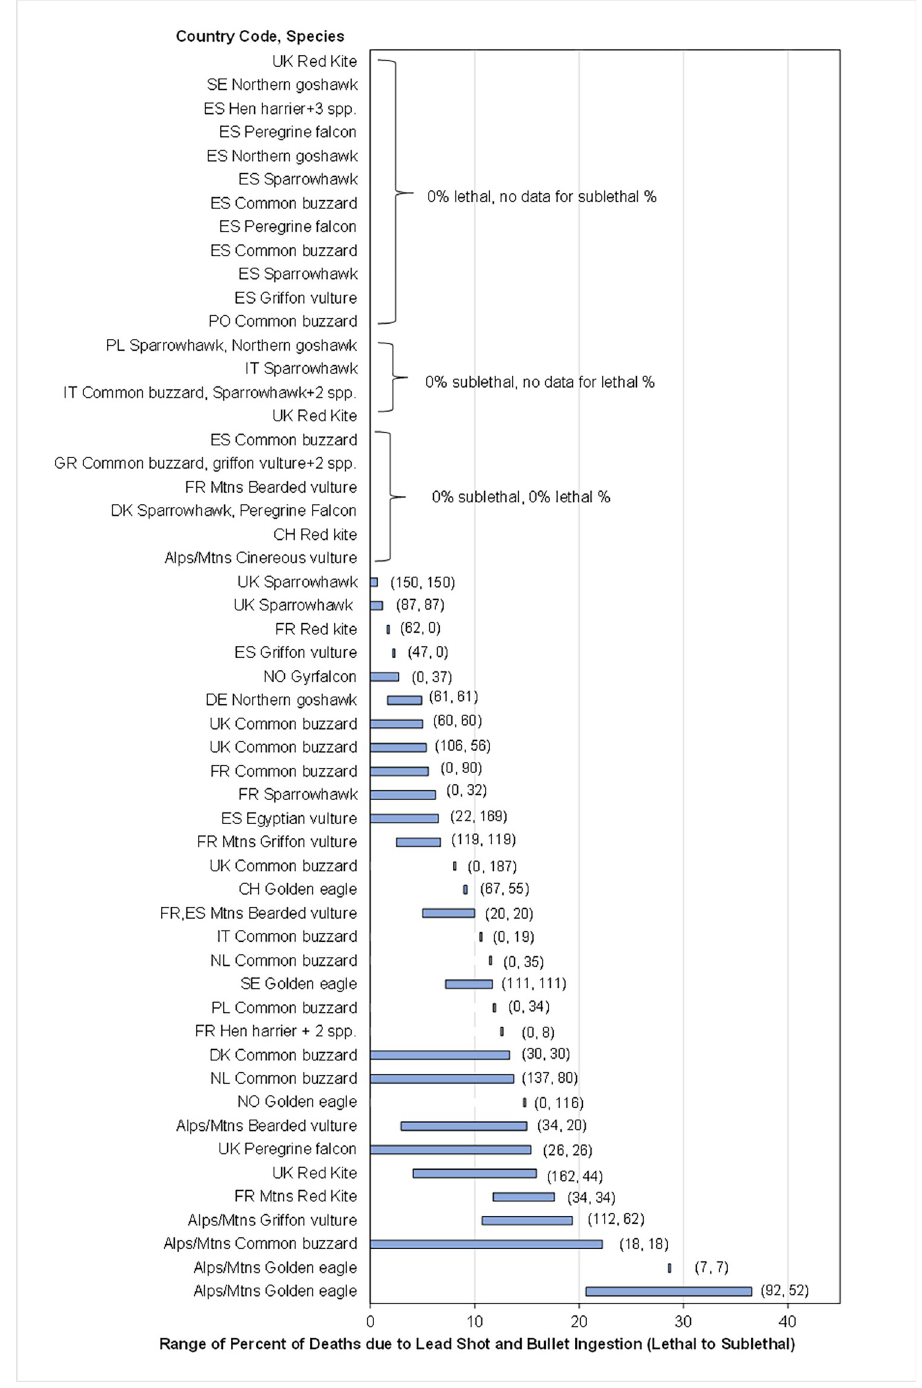
Fig 2. Estimated range of percentage of deaths due to lead ammunition ingestion in raptors (includes lead shot and bullets). Fig 1 describes bars, symbols, and abbreviations.